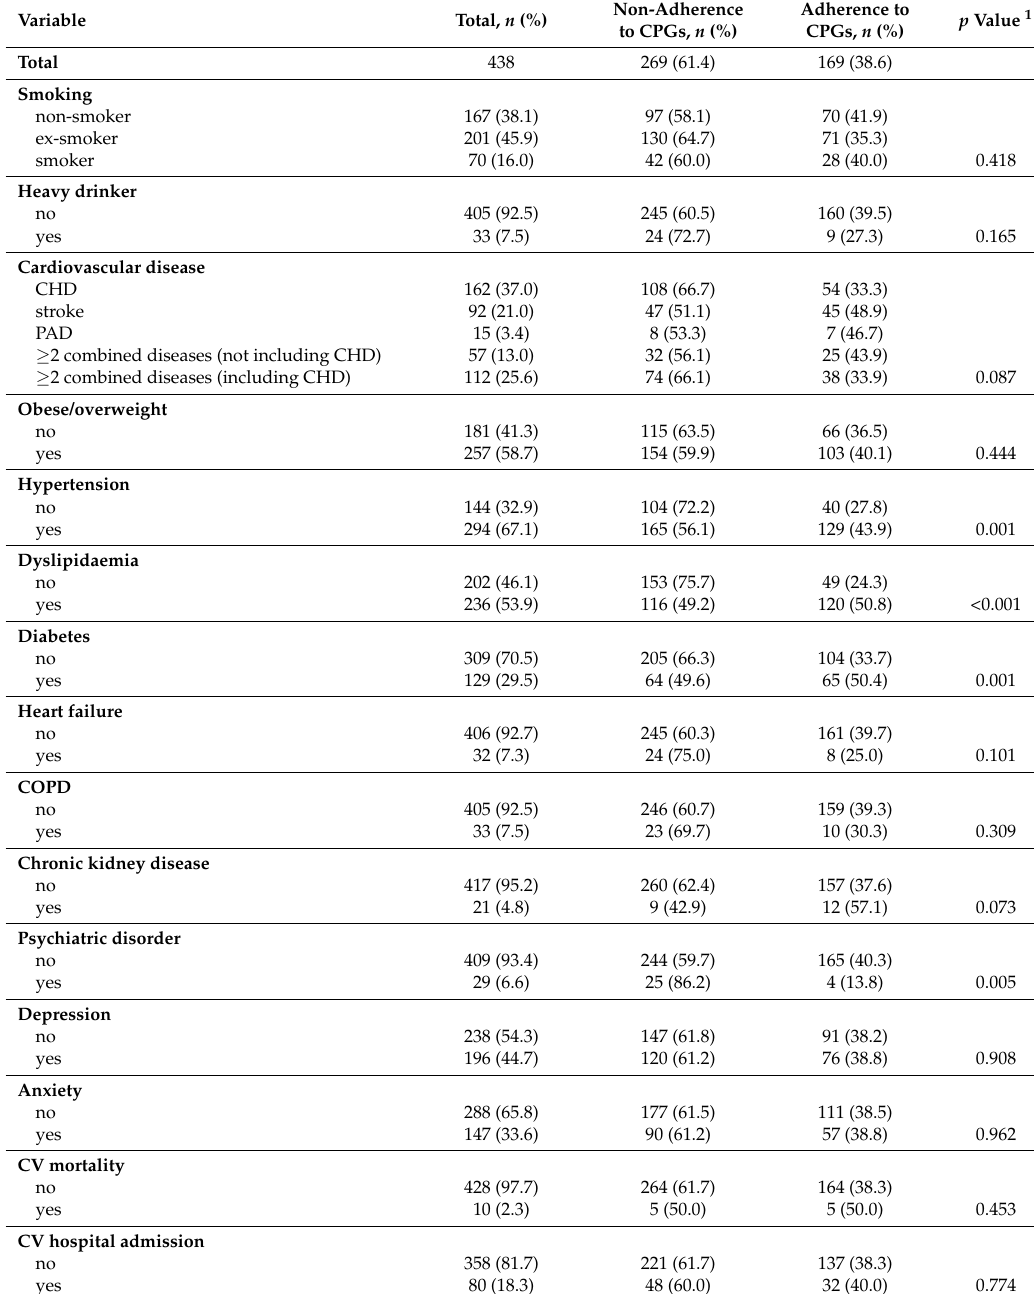
Table 2. Distribution of risk factors, type of cardiovascular disease and clinical history, by clinician adherence to clinical practice guidelines (CPGs) for secondary prevention of cardiovascular disease.